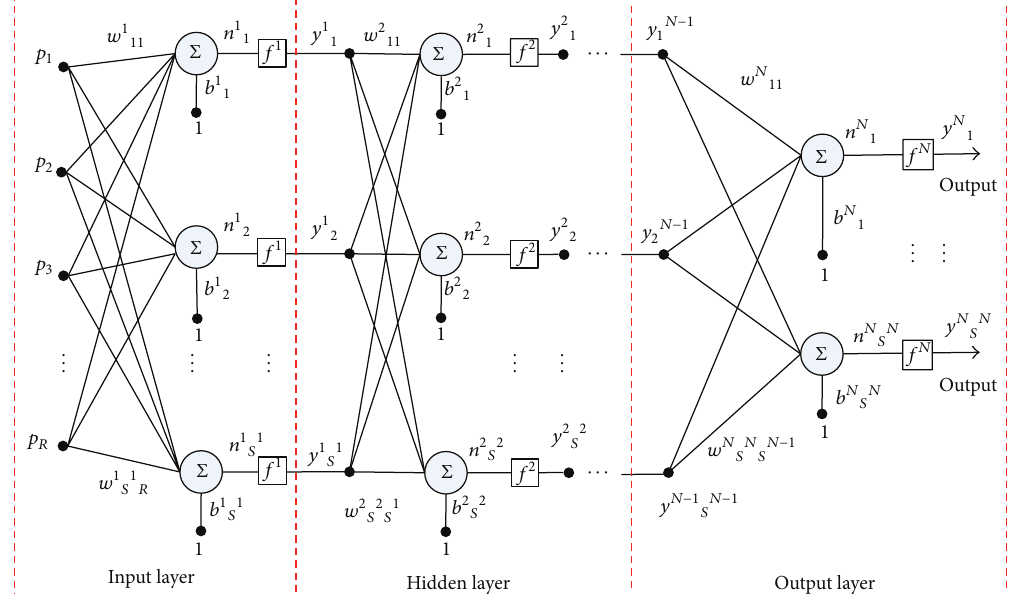
Figure 16: General structure of an artificial neural network.